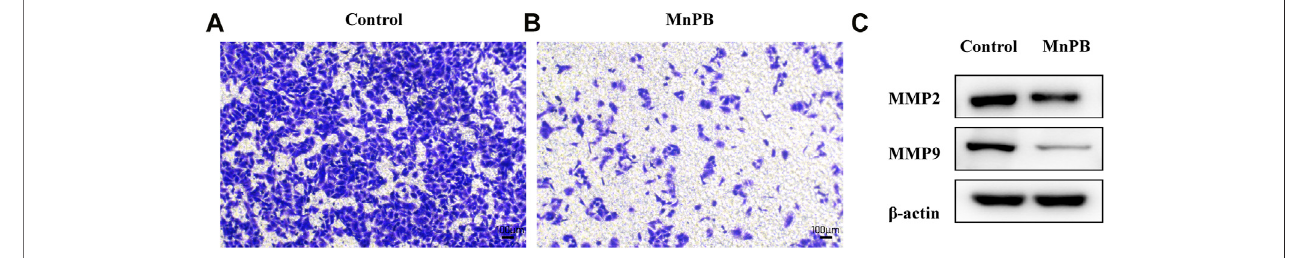
FIGURE6| TheMnPBNPsinhibitthemetastasisofnon-smalllungcancercells. (A) and (B) MigrationcapacityofA549cellsexposedtoMnPBNPs. (C) MMP2and MMP9 expression of A549 cells in different